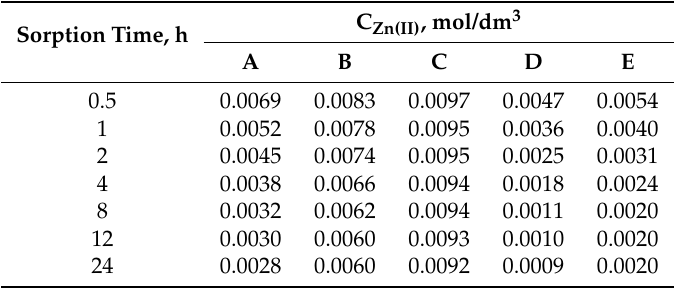
Table 4. Sorption time-dependent concentration of Cu(II) ions after the sorption on PVC-based